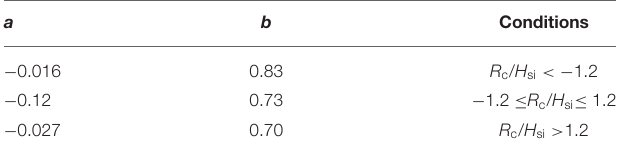
TABLE 2 | Empirical coefficients of the Equation